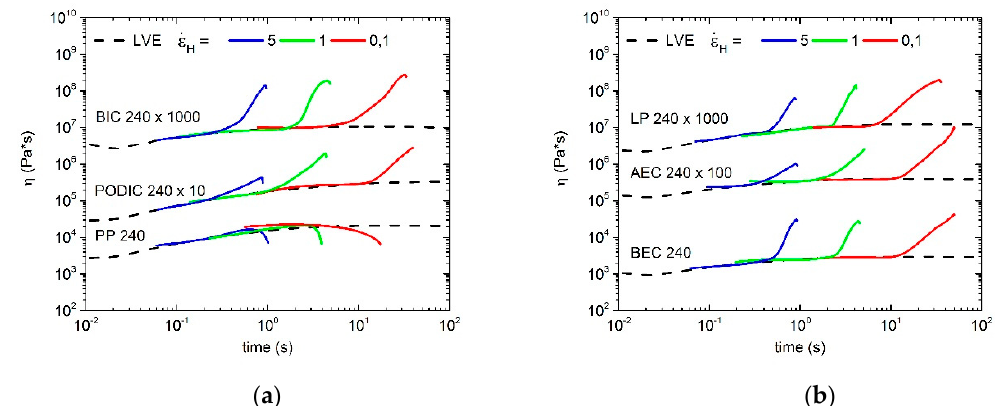
Figure 9. Extensional rheology of the different PP samples, (a) unmodified PP, PODIC and BIC; (b) BEC, AEC and LP, extruded at 240 °C; measured at 180 °C.